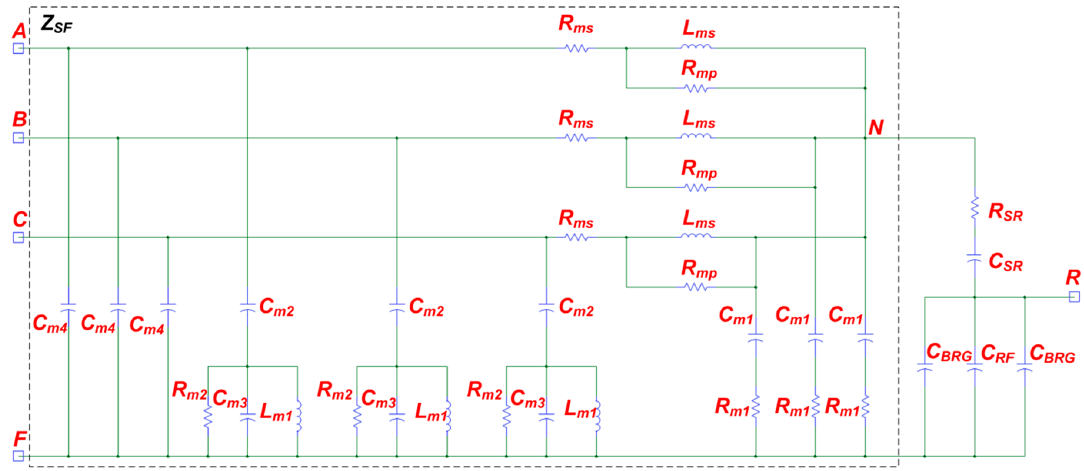
Figure 8. A model of IM common-mode impedance in the editing window of SABER simulator.